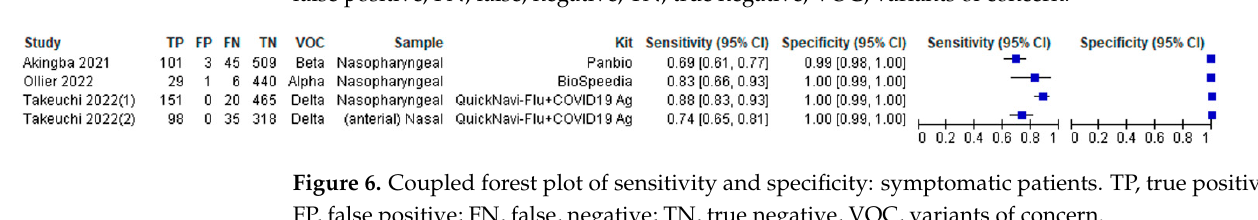
Figure 5. Coupled forest plot of sensitivity and specificity: mixed participants. TP, true positive; FP, false positive; FN, false, negative; TN, true negative, VOC, variants of concern.